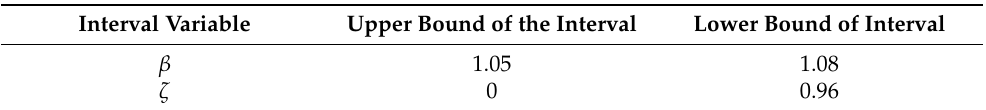
Table 3. Uncertainty description of each interval variable in the rotor mechanism design optimiza- tion